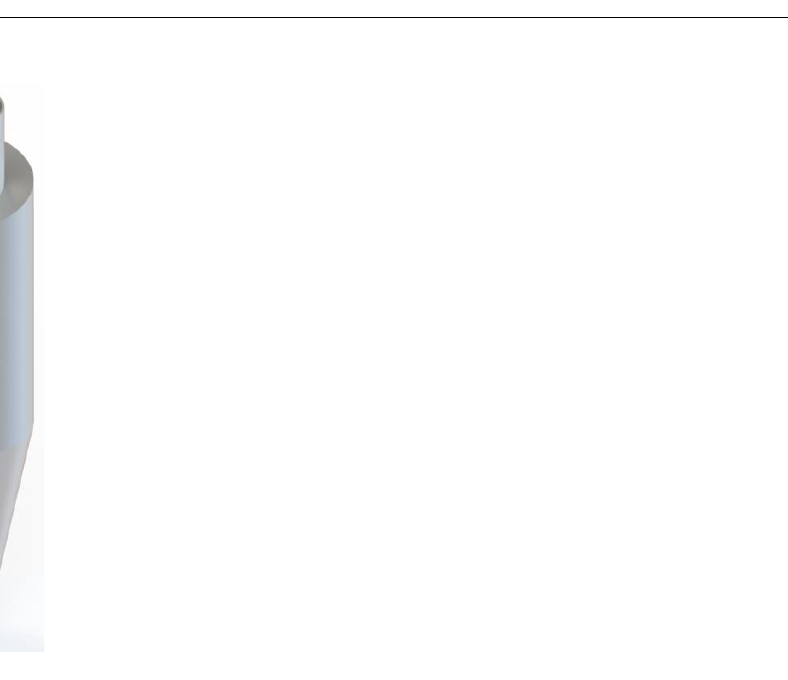
Figure 1. A real-world 3D model of the TsN-15 cyclone: (1) the inlet for the gas contaminated by the catalyst; (2) the outlet for catalyst particles collected during purification; and (3) the outlet for purified gas.